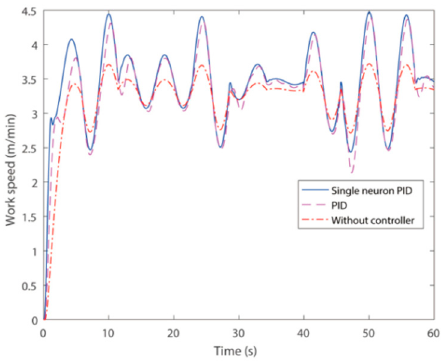
Figure 8. The machine work speed curves.